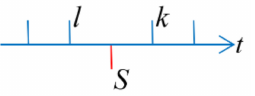
Figure 5. Linear interpolation of laser pose.